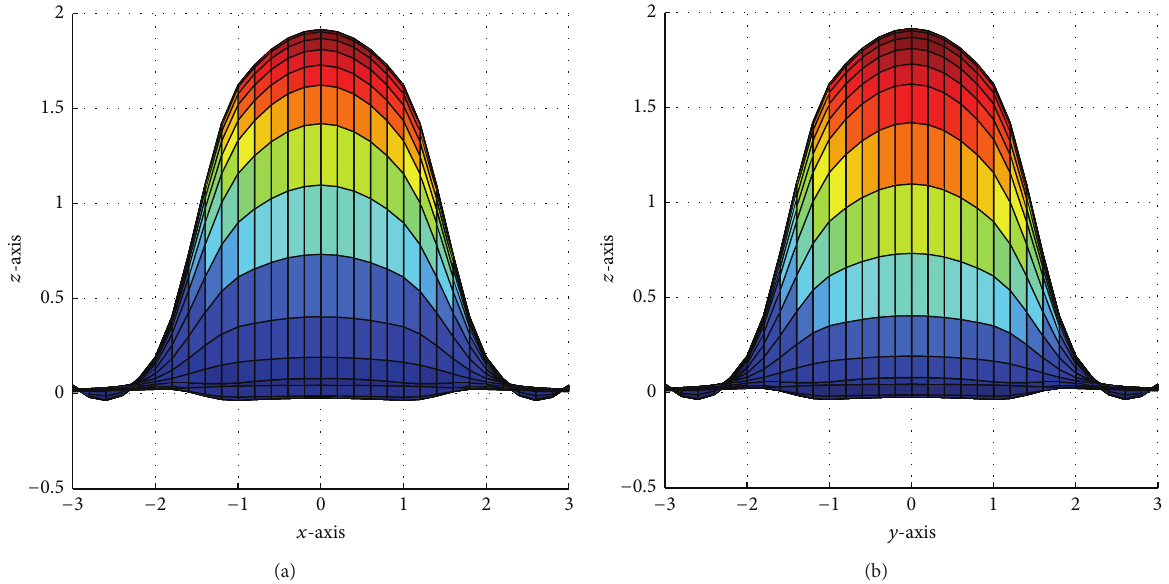
Figure 15: Bicubic Hermite surface: (a) 𝑥𝑧 -view and (b) 𝑦𝑧 -view for Figure 14, respectively.